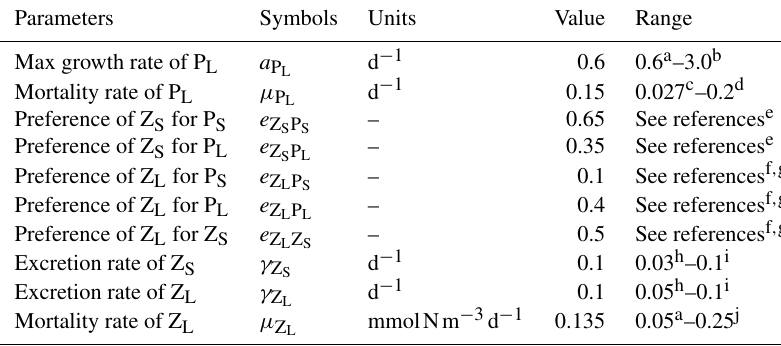
Table A1. Adjusted biological parameters and range of published parameter